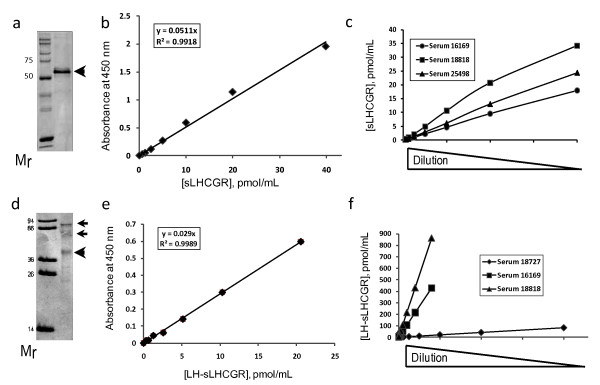
The sensitivity of sLHCGR and LH-sLHCGR ELISAs. The purity of the affinity purified recombinant LHCGR protein extracellular domain (a, indicated by an arrow) and LH-sLHCGR (d, indicated by arrows) proteins were examined in SDS-polyacrylamide gels-stained with coomassie blue. The small arrows above the major band in d) are either glycosylated or dimers because these bands react with anti-FLAG and LHR29 monoclonal antibodies. The sensitivity of the ELISAs was verified by linear responses to the dilution effect of sLHCGR (b) and LH-sLHCGR protein calibrators (e). The sensitivities of these assays were further examined by assaying serially diluted serum samples from three patients with known concentration of sLHCGR (c) and LH-LHCGR (f). Each data point in b and e represents mean value obtained from six independent dilution of the standards.